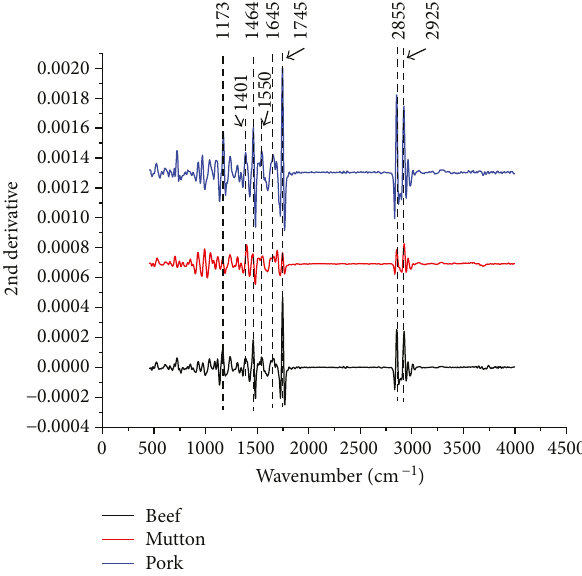
Figure 3: 2nd derivative spectrum of pork, beef, and